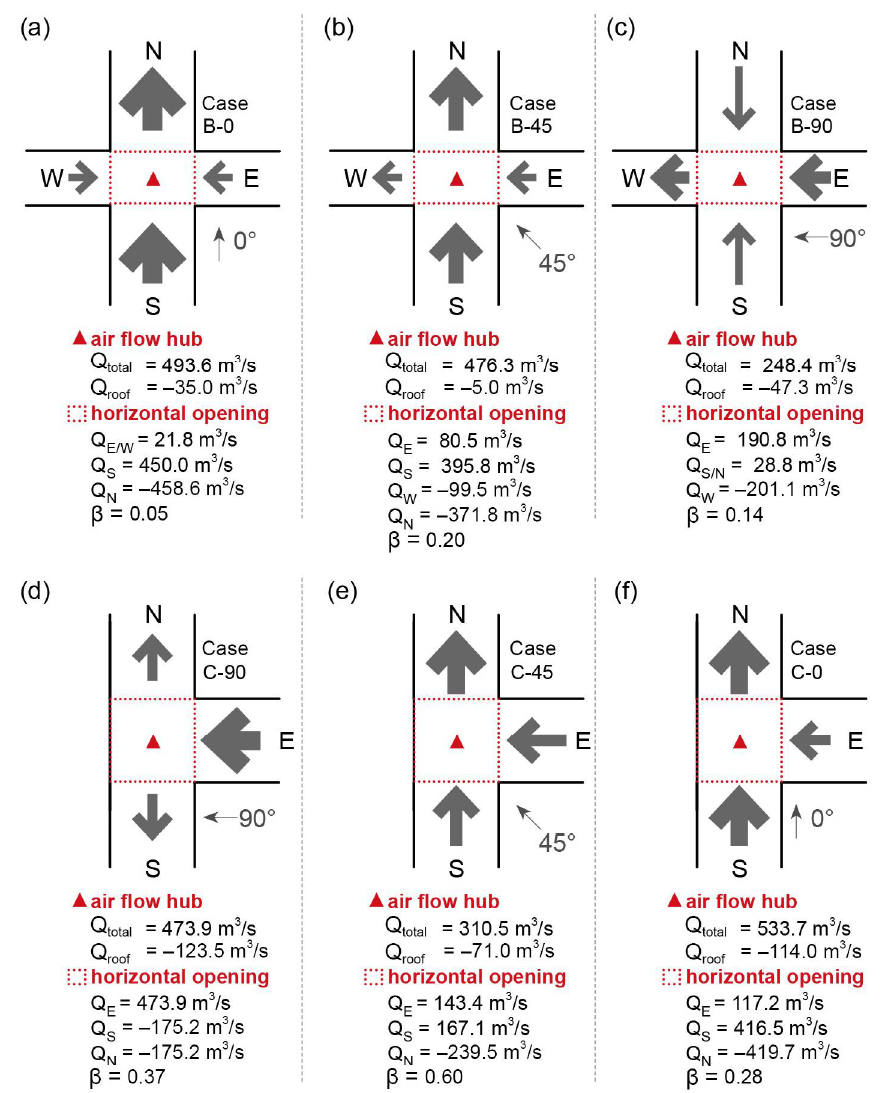
Figure 9. Volumetric flow rate for intersections and interfaces in Cases ( a ) B-0, ( b ) B-45, ( c ) B-90, ( d ) C-90, ( e ) C-45, and ( f ) C-0. Table 1. Spatially averaged normalized pollutant concentration for the pedestrian zone (C ∗ near-wall zone (C ∗ nwz ), and the canopy layer (C ∗ cnp ) at right-angled intersections. Cases C *